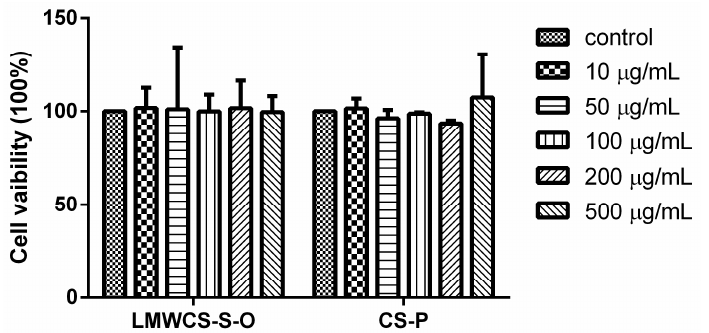
Figure 4. Cytotoxic effect of LMWCS-S-O and CS-P on articular chondrocytes after the treatment with LMWCS-S-O and CS-P for 24 h.